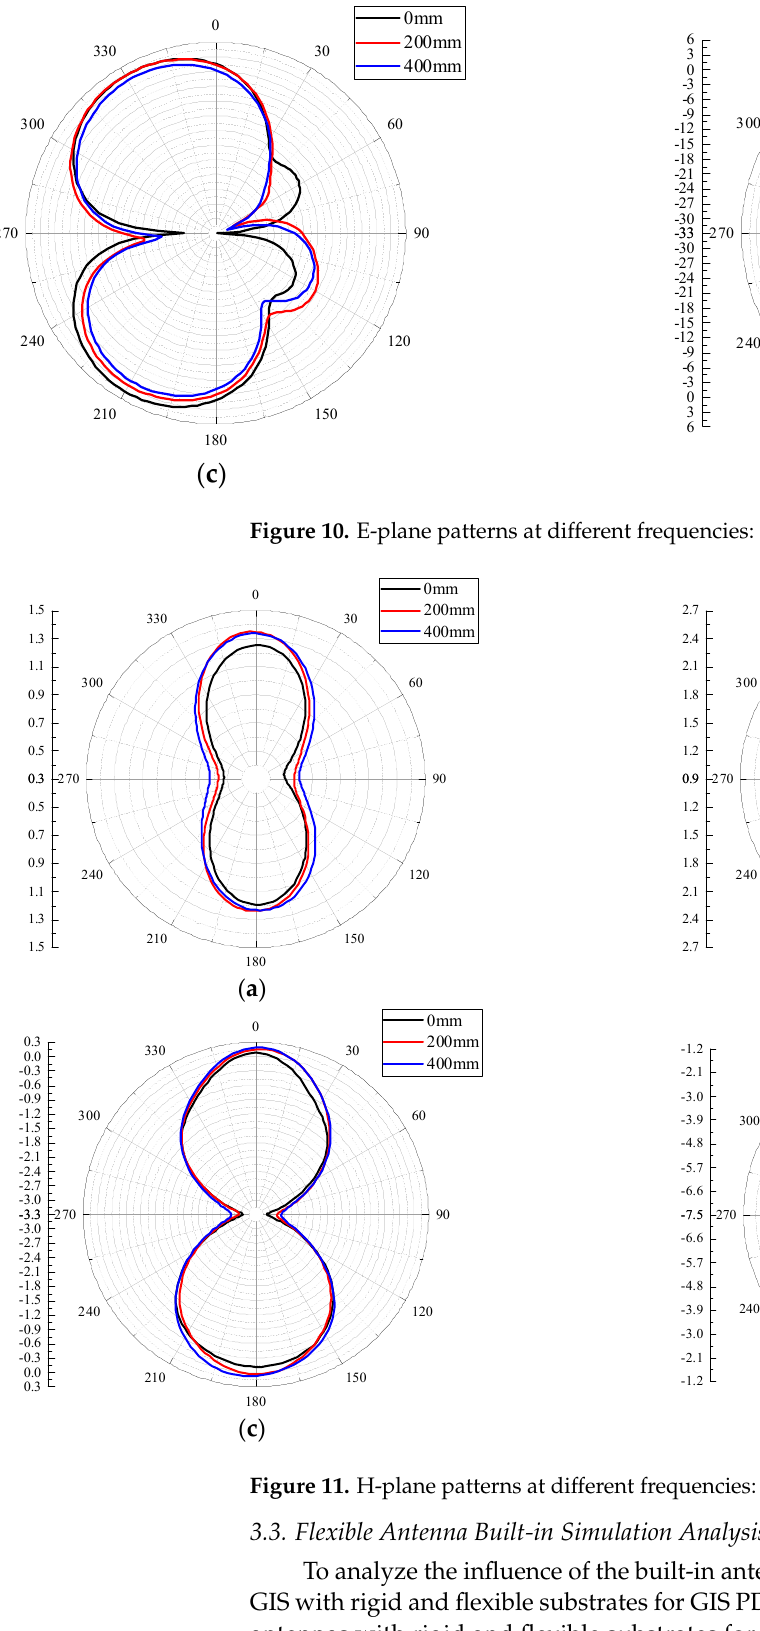
Figure 11. H-plane patterns at different frequencies: ( a ) 0.5 GHz; ( b ) 0.7 GHz; ( c ) 1 GHz; ( d ) 1.5 GHz.